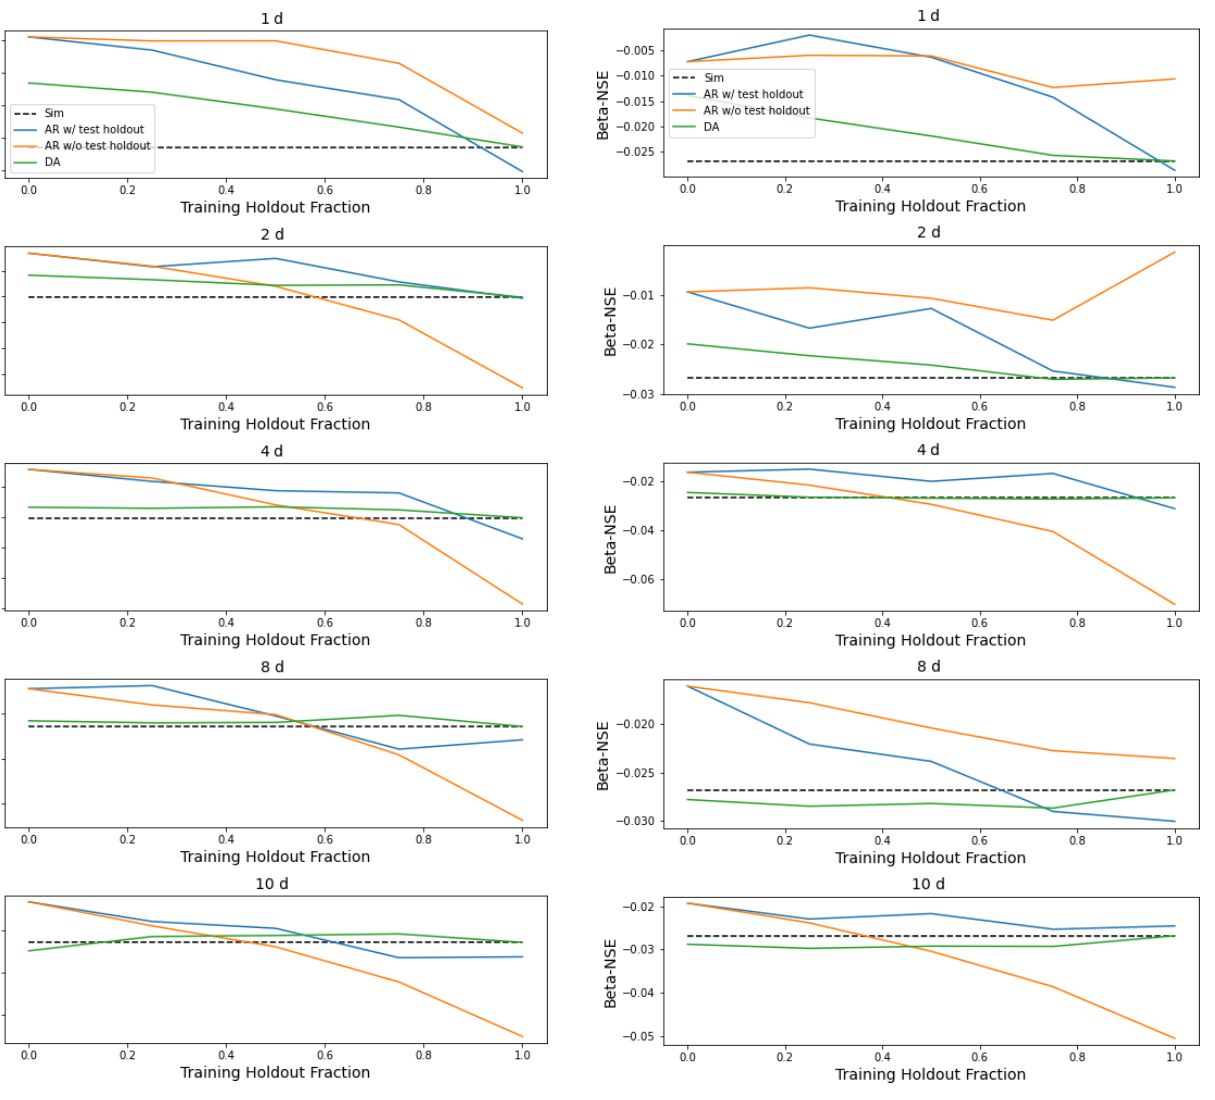
Figure H4. Same as Fig. 4 but for β -NSE, which is the ratio of the means of the observed vs. modeled